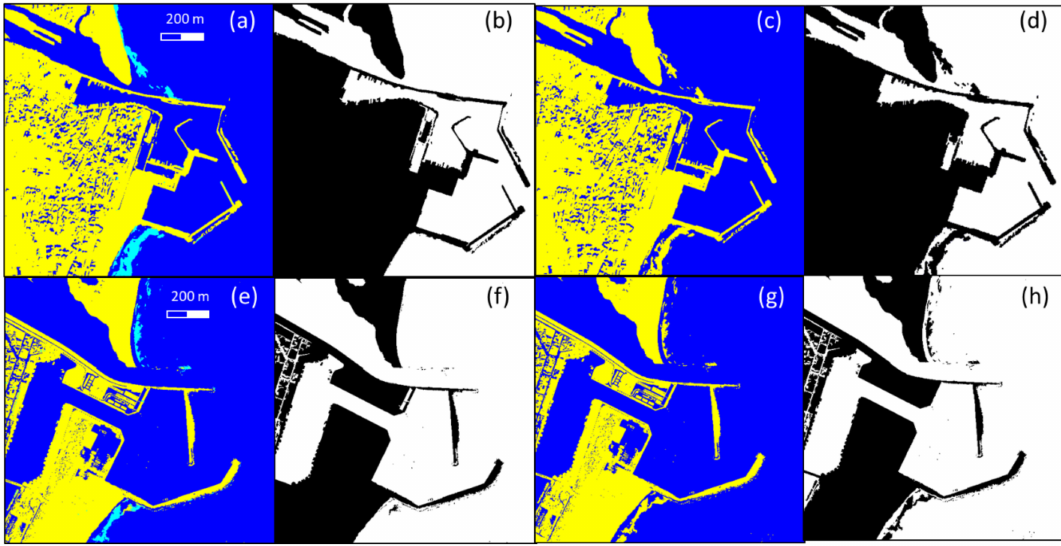
Figure 6. First line ( a – d ): Support Vector Machine (SVM) classification on the southern area on 8 November 2010 when 3 classes (land, foam and water) were used ( a ) and when 2 classes (land and water) were used ( c ). ( b , d ): land / ocean maps obtained after merging water and foam pixels through the segmentation process. Second line ( e – h ): SVM classification on the northern area on 10 August when 3 classes (land, foam and water) were used ( e ) and when 2 classes (land and water) were used ( g ). ( f , h ): land / ocean maps obtained after merging water and foam pixels through the segmentation